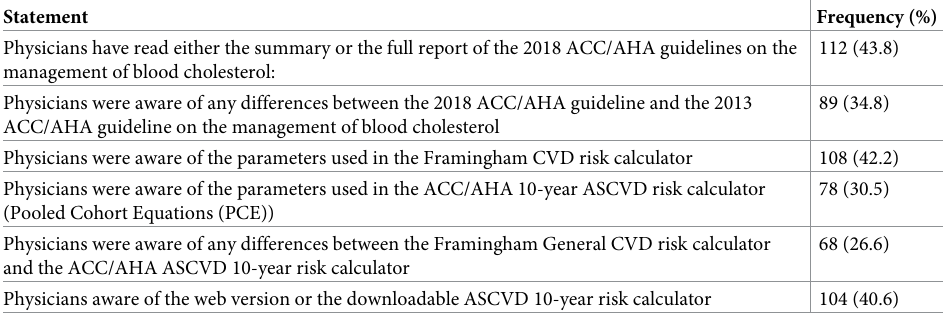
Table 2. Response of physicians to the general awareness questions about guidelines and risk